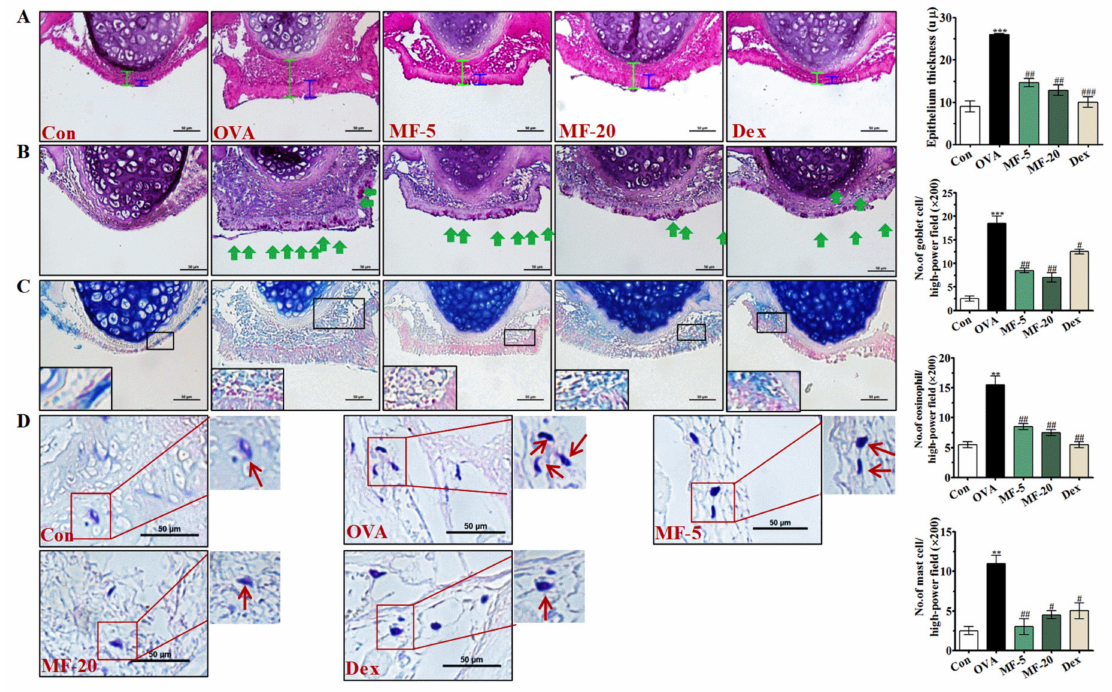
Figure 2. E ff ect of MF on histological changes in nasal tissues of OVA-induced AR mice. ( A ) The general histology, epithelium thickness of nasal mucosa, HE staining; Scale bar = 50 µ m. ( B ) Goblet cells hyperplasia. PAS staining; the green arrow indicates the goblet cell; Scale bar = 50 µ m. ( C ) Infiltration of the eosinophils, Giemsa staining; Scale bar = 50 µ m. ( D ) Mast cells immigration in the nasal mucosa. Giemsa staining; Scale bar = 50 µ m. Red arrow indicates the mast cells. Values are presented as the mean ± SEMs ( n = 6 per group). ** p < 0.01, *** p < 0.001 , significantly di ff erent from the value of Control group. # p < 0.05, ## p < 0.01, ### p < 0.001 , significantly di ff erent from the value of OVA